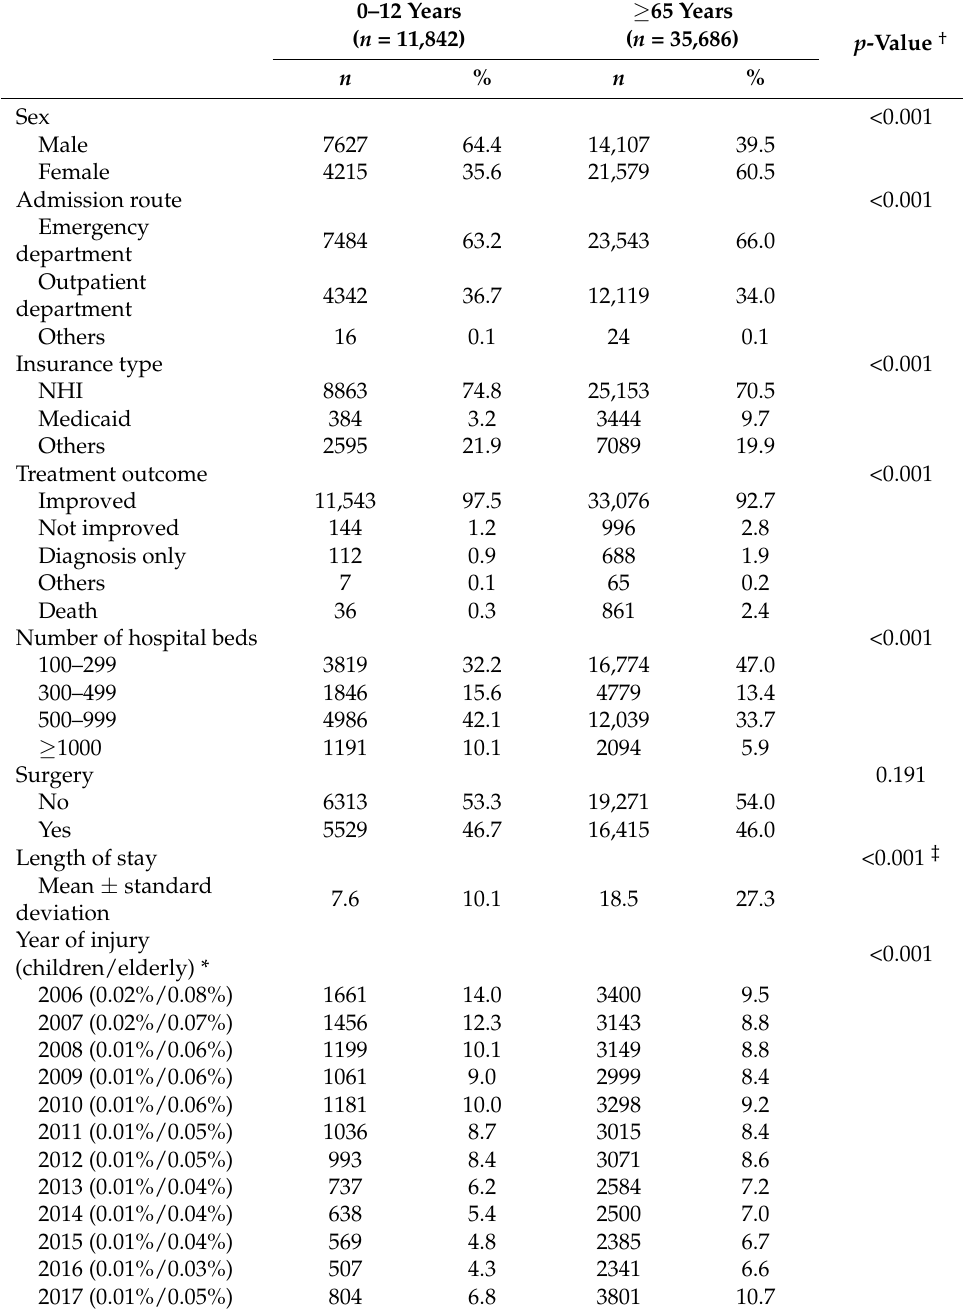
Table 1. Sociodemographic characteristics of discharged pediatric and elderly